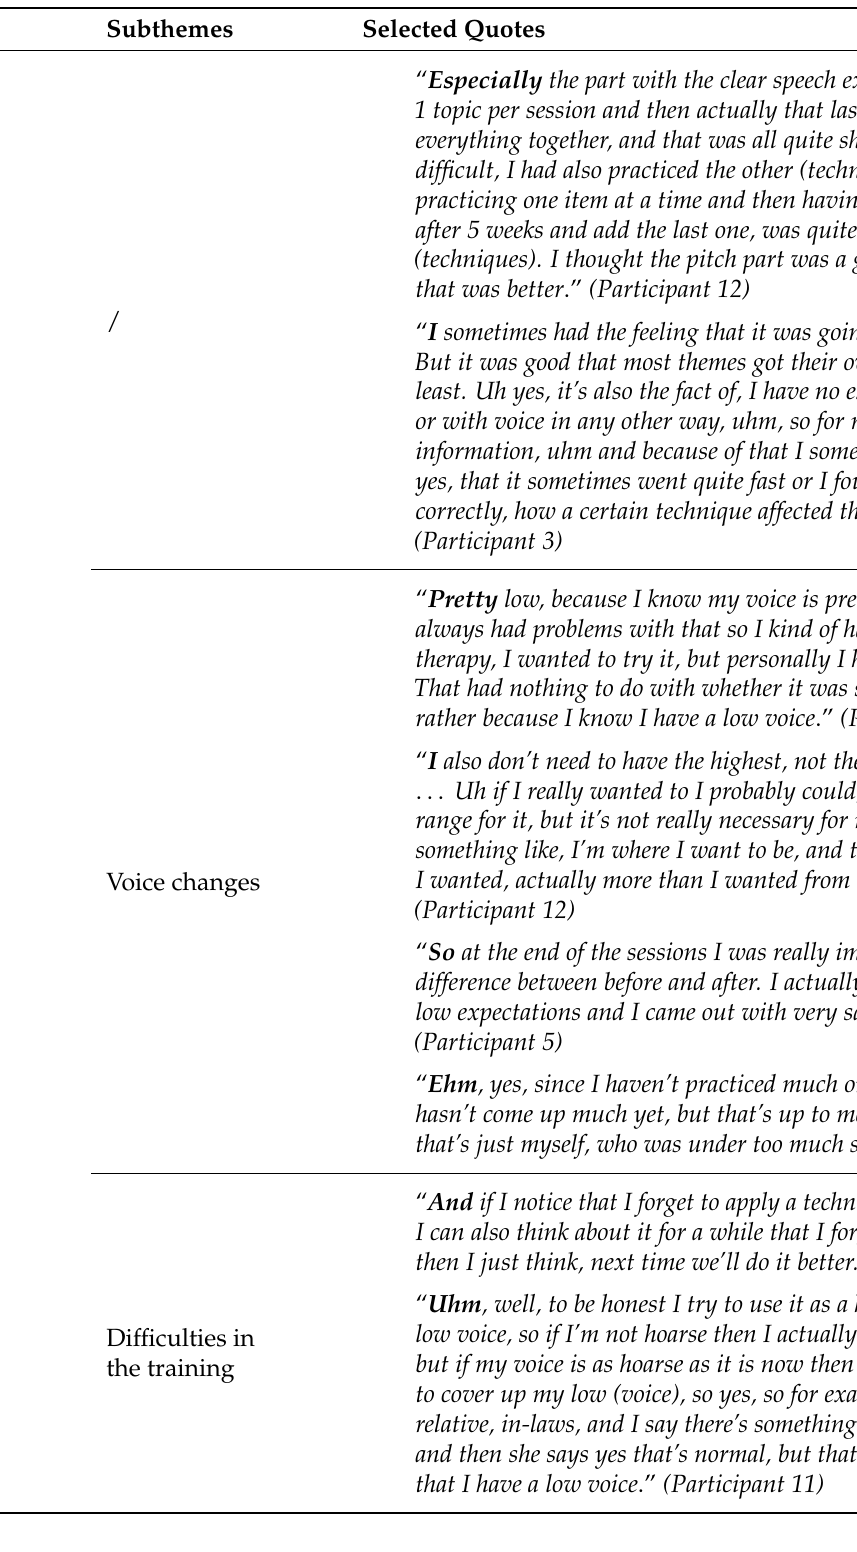
Table A3. Table with Themes, Subthemes and Selected